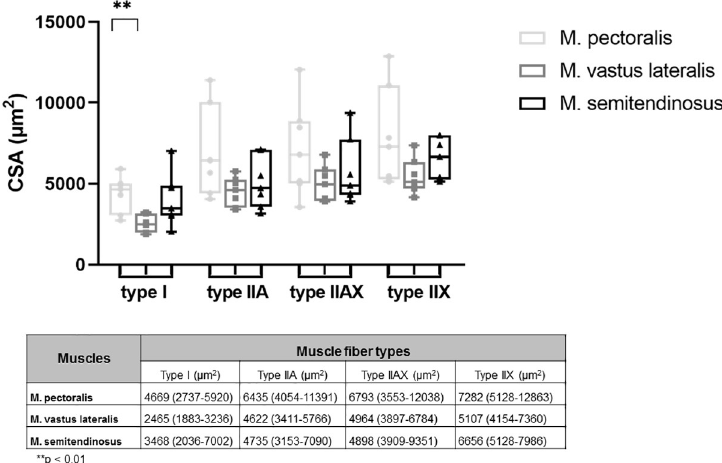
Fig 7. Cross sectional area of type I, IIA, IIAX and type IIX muscle fibers in different muscles. Results are given as median (minimum-maximum) in μ m 2